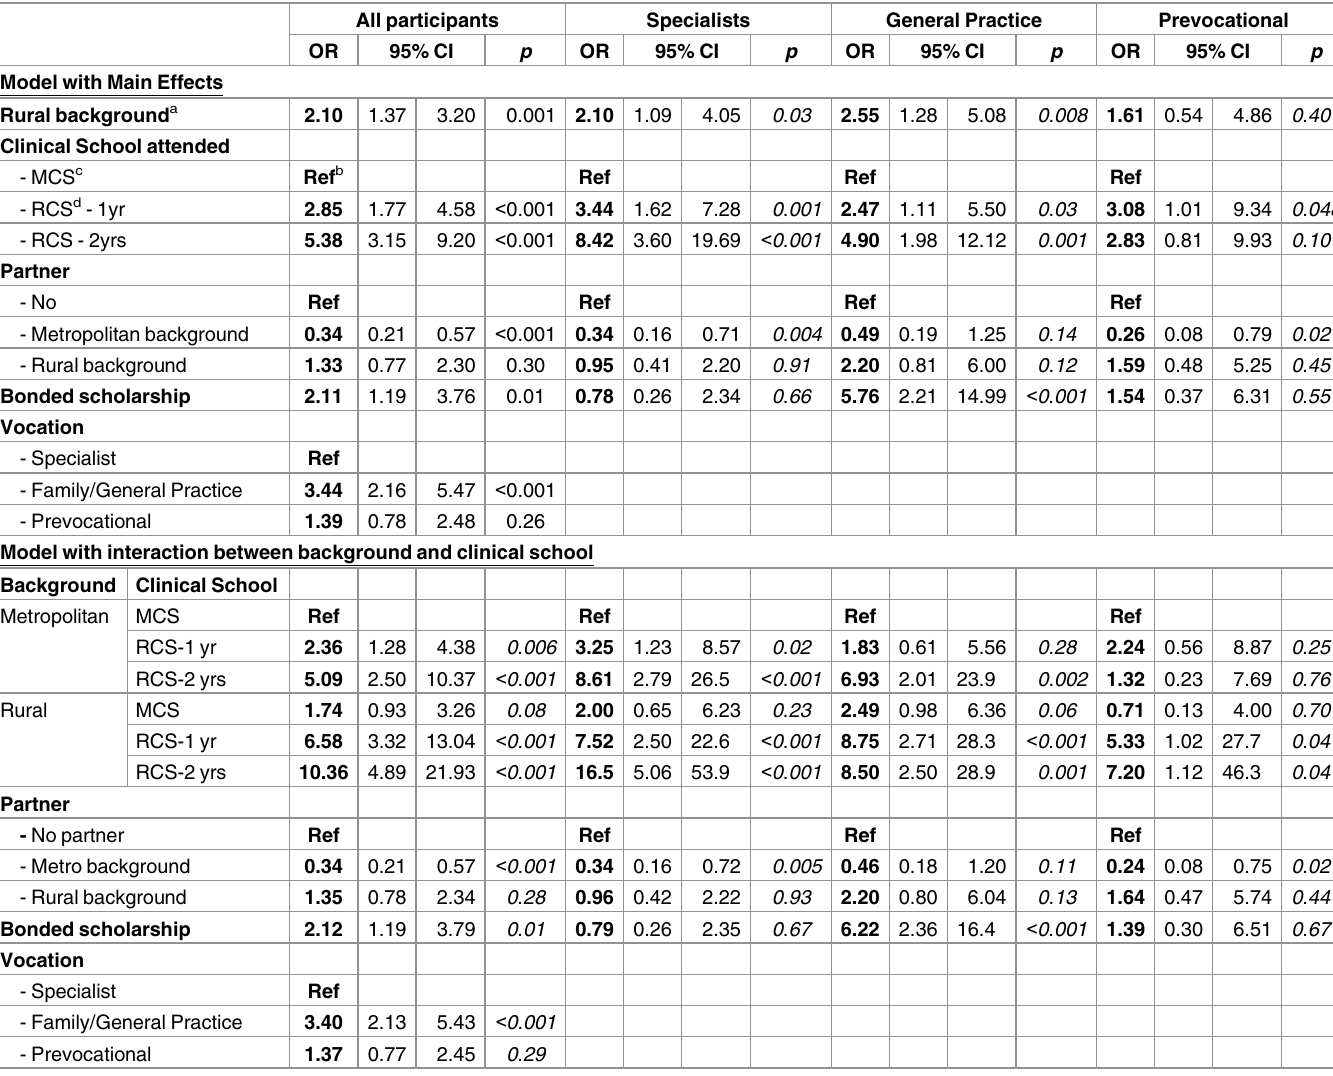
Table 3. Multivariate logistic regression models predicting rural practice (cid:21) 50% of time since graduation. All